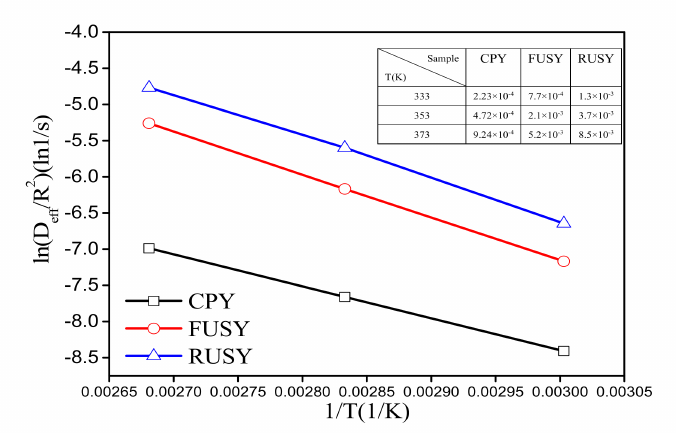
Figure 5. Evolution of methylcyclohexane (MCH) conversion versus reaction time on the three Y-zeolite